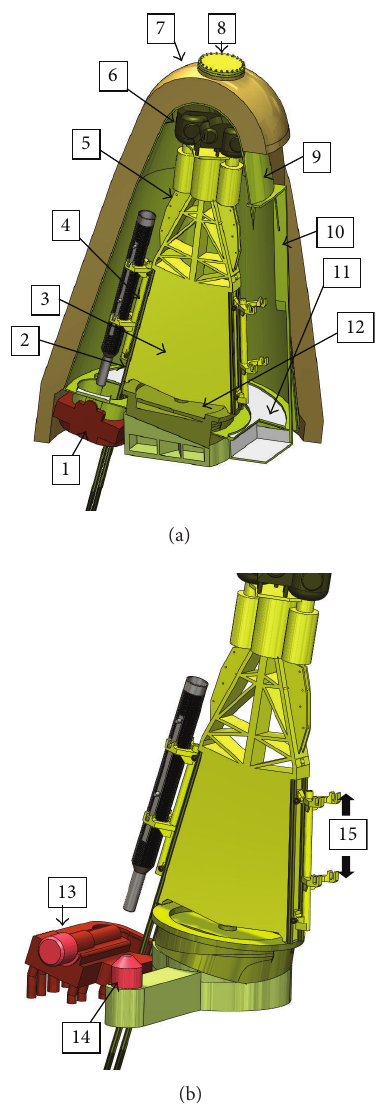
Figure 5: Detailed view of the ramp/gas corridor interface rotating